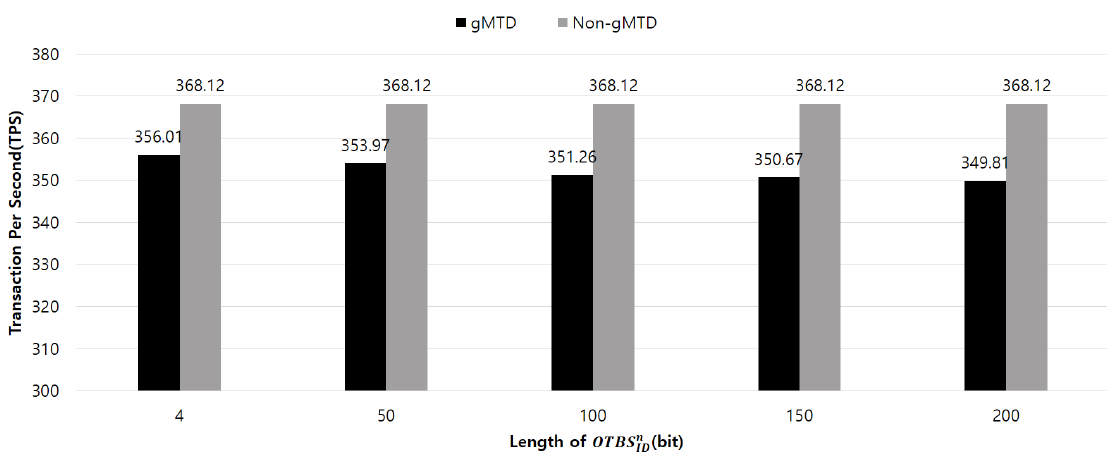
Figure 6. Measuring transaction per second (TPS) with varying length of OTBS n